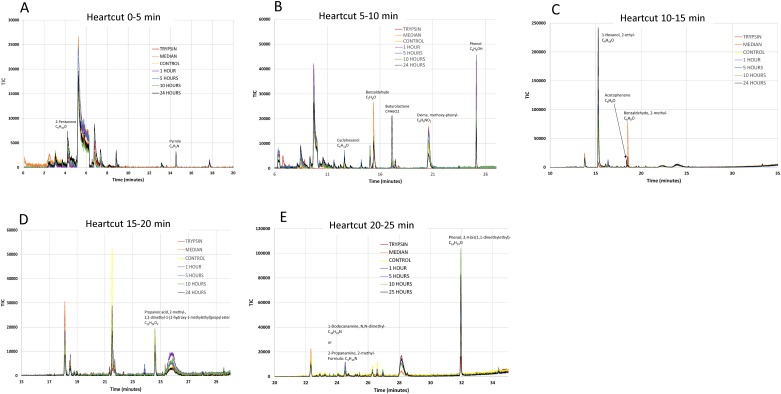
Overview of VOC characterization.The chromatograms were recorded using a 2D GC-GC configuration (heartcut) to attain better VOC separation prior to identification using a MS. The heartcut time periods logged are A. 0–5 min; B. 5–10 min; C. 10–15 min; D. 15–20 min; and E. 20–25 min.